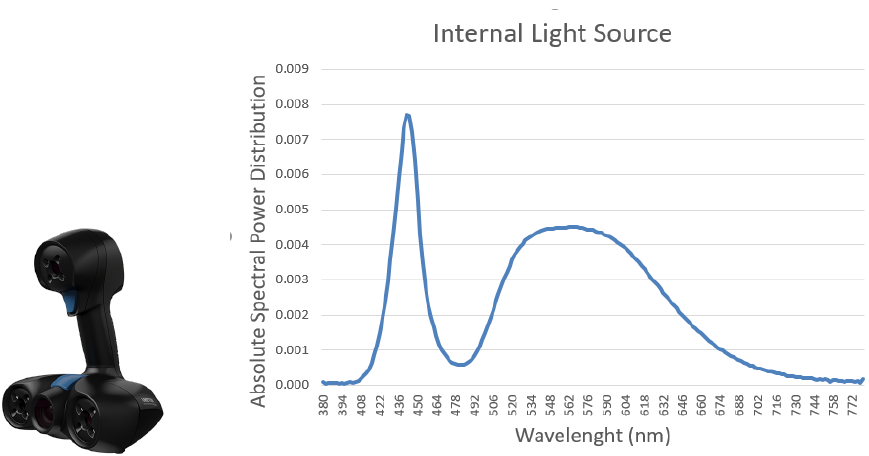
Figure 3. Scanner used for the object simulation process ( left ) and spectral power distribution of the scanner ( right